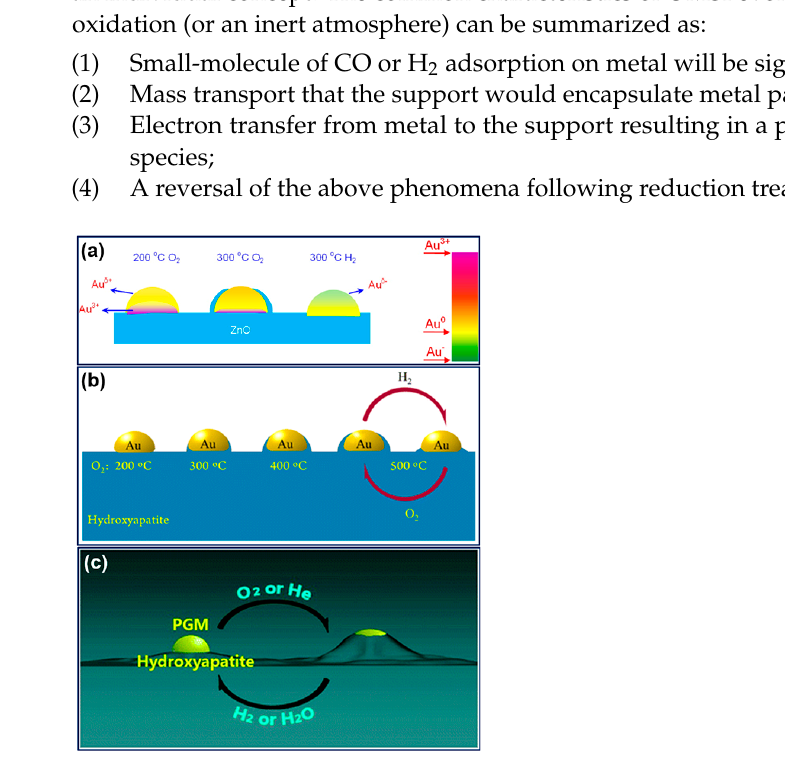
Figure 2. Schematic illustration of OMSI for ( a ) Au/ZnO-nanorod, reproduced with permission from [44], copyright: 2012 by the American Chemical Society, ( b ) Au/HAP, reproduced with permission from [45], copyright: 2016 by the American Chemical Society, and ( c ) HAP supported Pt-group metals, reproduced with permission from [46], copyright: 2018 by The Royal Society of Chemistry. Table 1. Comparison between OMSI and classical SMSI.